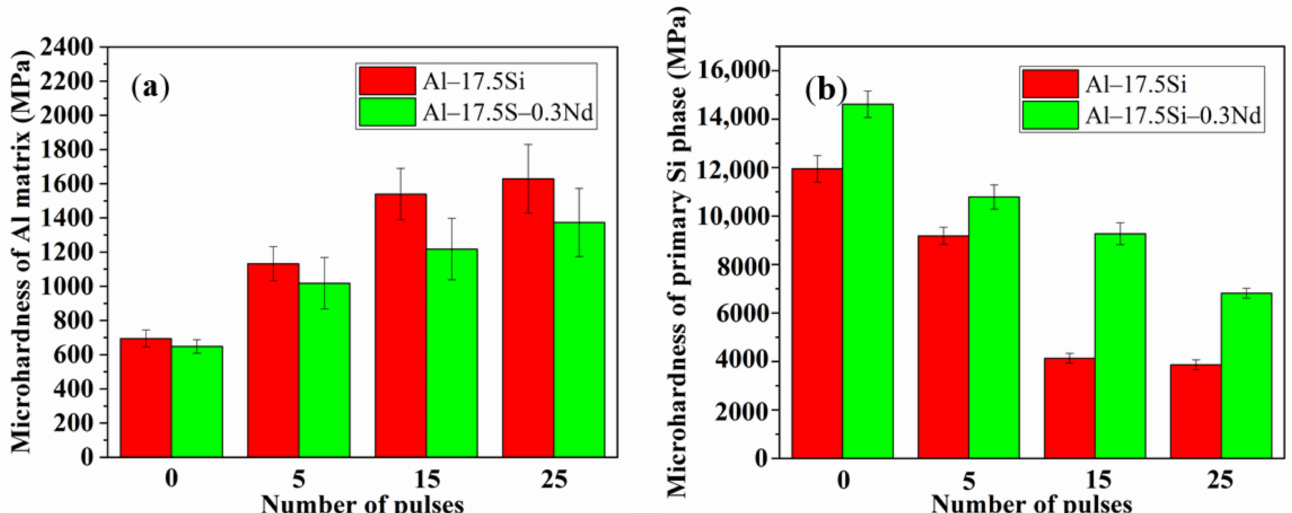
Figure 5. The relation between the microhardness of Al–17.5Si and Al–17.5Si–0.3Nd alloy surfaces and the number of pulses. ( a ) Al matrix; ( b ) Primary silicon